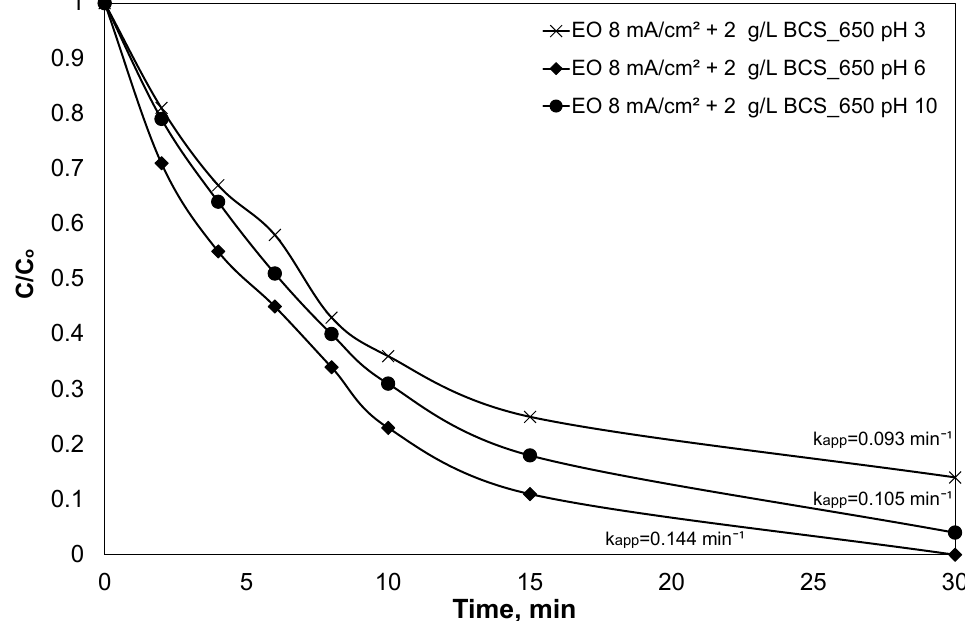
Figure 5. Effect of BCS_650 loading on the degradation of SMX in the combined 3D process. Condi- tions: [SMX]° = 500 μ g/L, [Na 2 SO 4 ] = 0.1 M, j = 8 mA/cm 2 , ultrapure water.